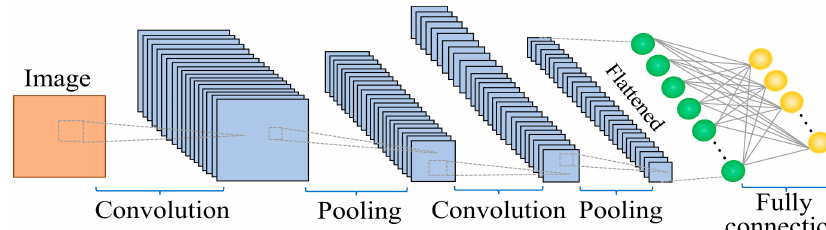
Figure 2. Example of CNN structure.